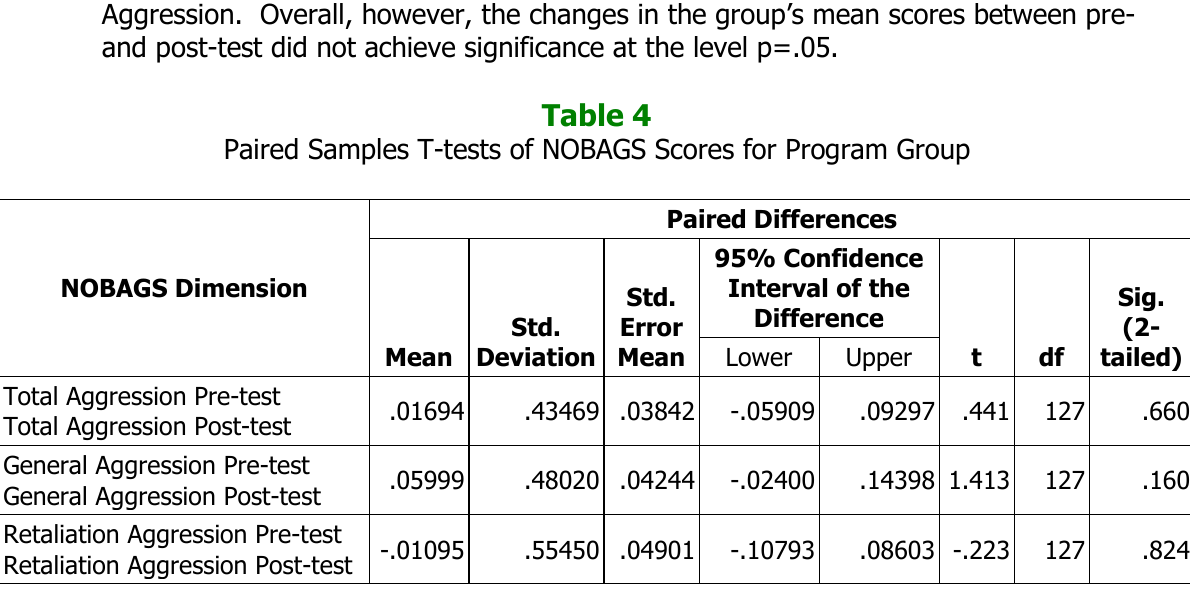
Paired Samples T-tests of NOBAGS Scores for Program Group NOBAGS Dimension